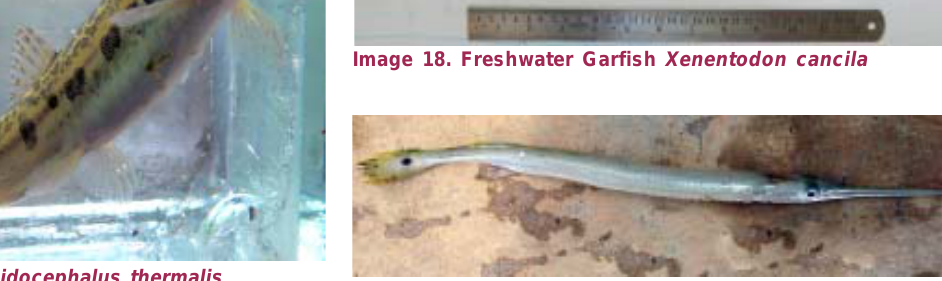
Image 19. Spot-tailed Gar Strongylura strongylura